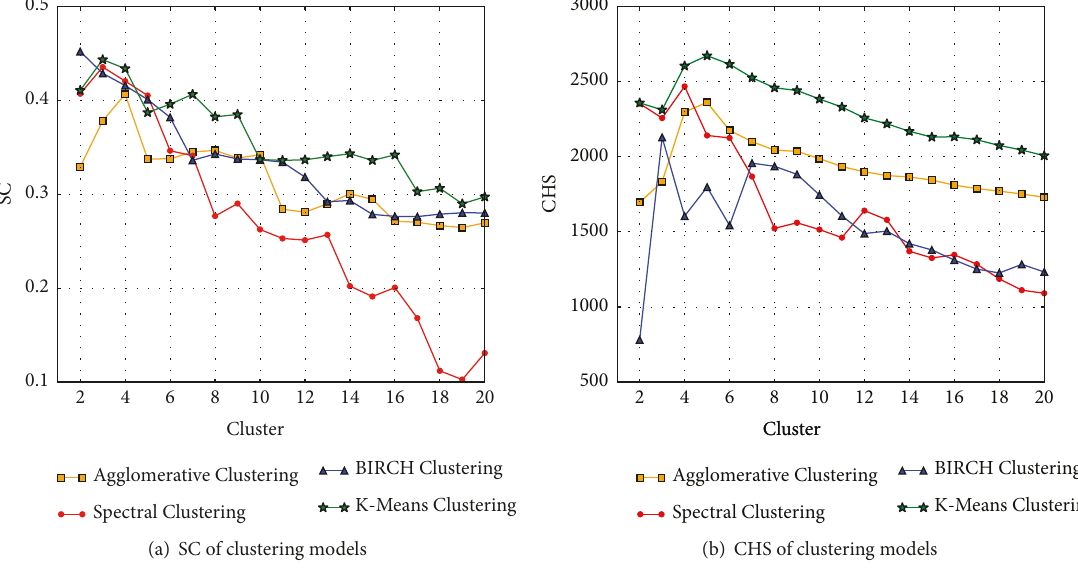
Figure 5: SC and CHS of clustering